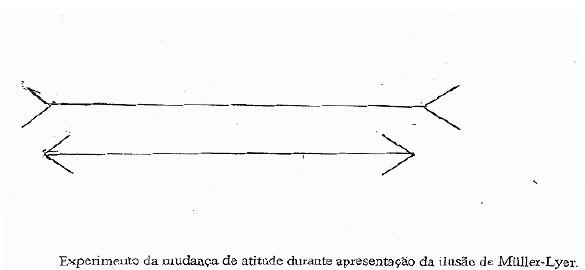
Figura 2. Estimula(cid:231)ªo no experimento de Benussi